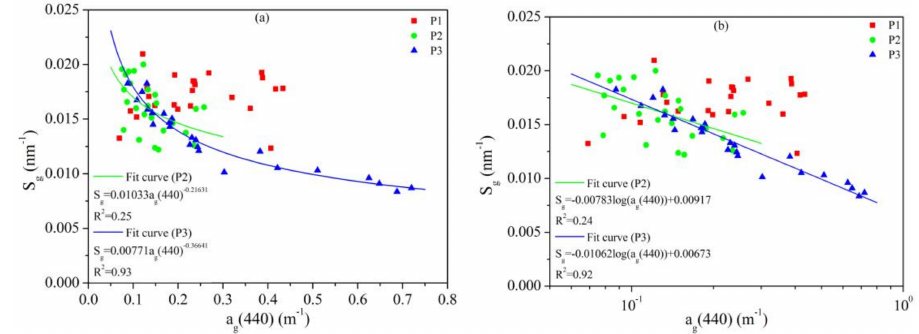
Figure 6. Power law relationship between a g (440) and S g ( a ), and inverse linear relationship between the logarithm of a g (440) and S g ( b ), at Stations P1 (red squares, N = 23), P2 (green circles, N = 25), and P3 (blue triangles, N = 24). The solid lines represent the fitted lines using the equations shown in the figure. The coefficients of determination R 2 are shown in the figure. There is a strong negative relationship between a g (440) and S g at Station P3, and a weak negative relationship at Station P2, but no observed relationship at Station